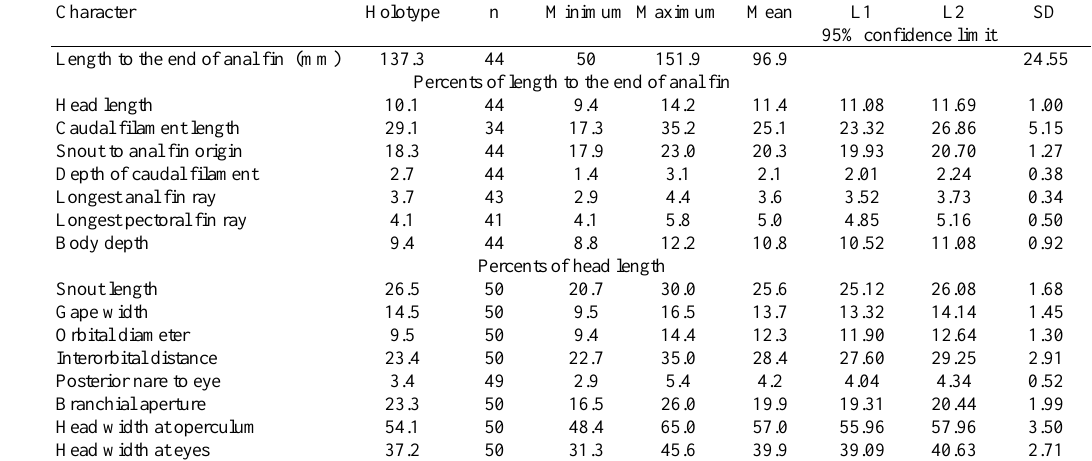
Table 1. Morphometric data for Brachyhypopomus draco .